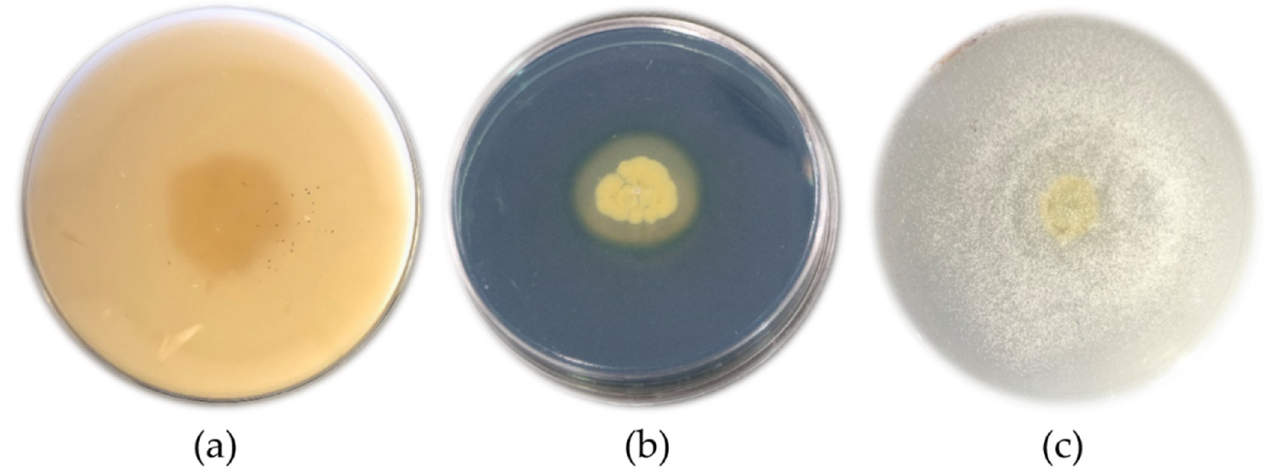
Figure 2. The ability of Bacillus velezensis to produce some metabolites. ( a ) The positive proteolytic activity of B. velezensis shows a clear halo around the bacterial colony; ( b ) the positive activity of B. velezensis in the production of siderophore changes the color of the medium to orange; ( c ) the positive activity of B. velezensis dissolves phosphate as seen by the presence of a colorless halo around the colony.